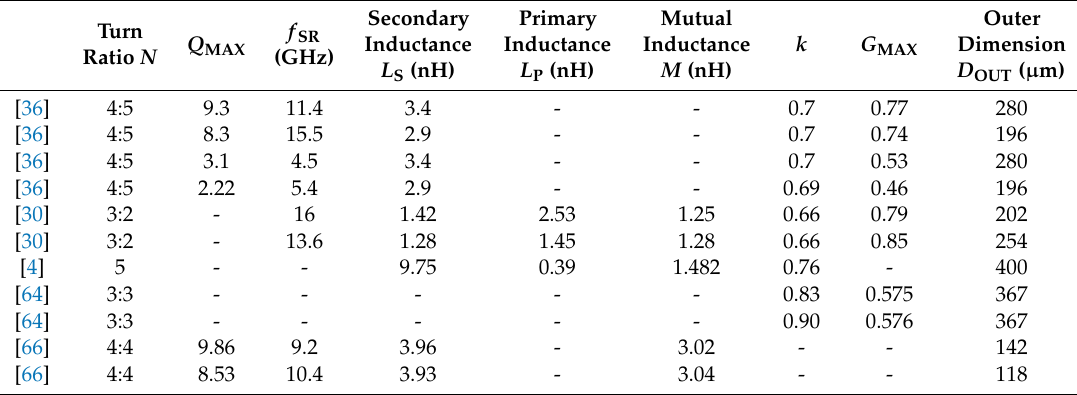
Table 1. Comparison of di ff erent on-chip transformers using interleaved planar